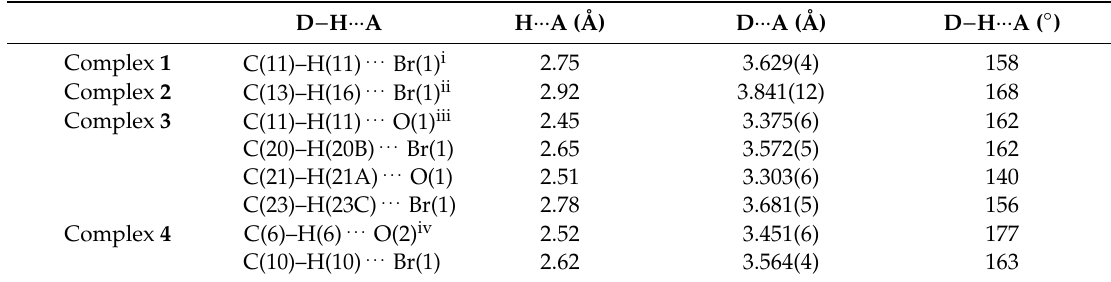
Table 3. Hydrogen bonding interaction parameters in complexes 1–4